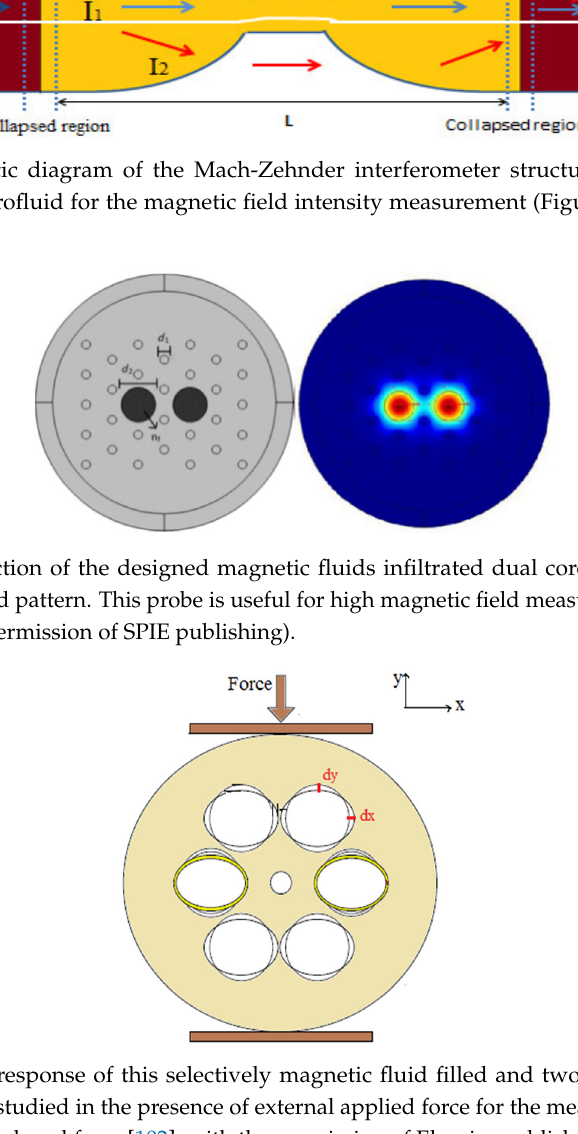
Figure 36. Spectral response of this selectively magnetic fluid filled and two cascaded gold layer incorporated PCF is studied in the presence of external applied force for the measurement of external magnetic field (Reproduced from [102], with the permission of Elsevier publishing).